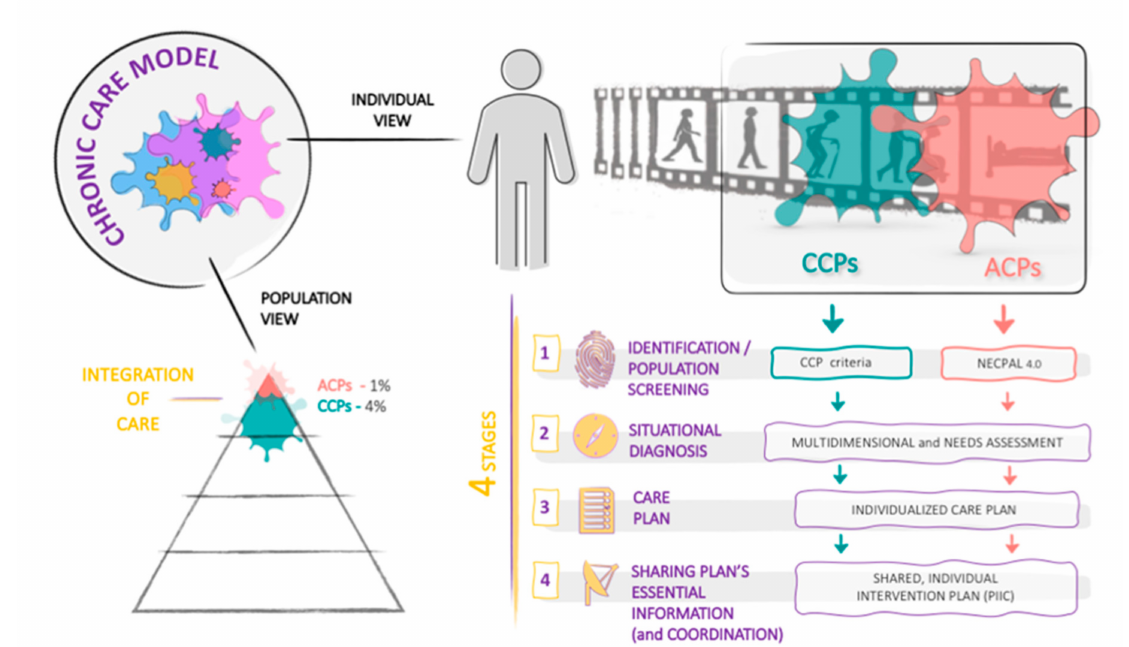
Figure 2. Diagram depicting the model of care for persons with complex chronic conditions and advanced chronic conditions of the Catalan health program 2011–2015 from the individualized and population perspectives. The model is organized in four main stages. ACPs, advanced chronic patients; CCPs, complex chronic